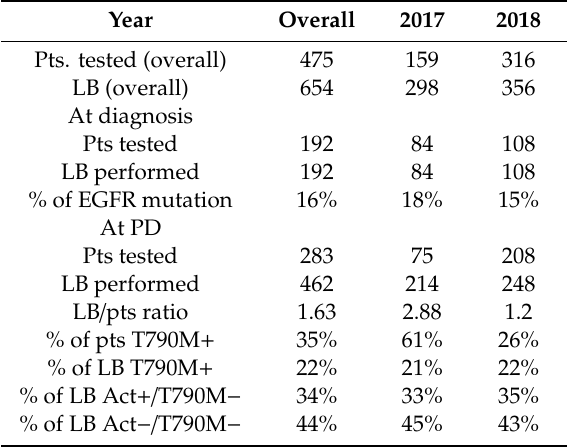
Table 1. Number of patients tested and liquid biopsy